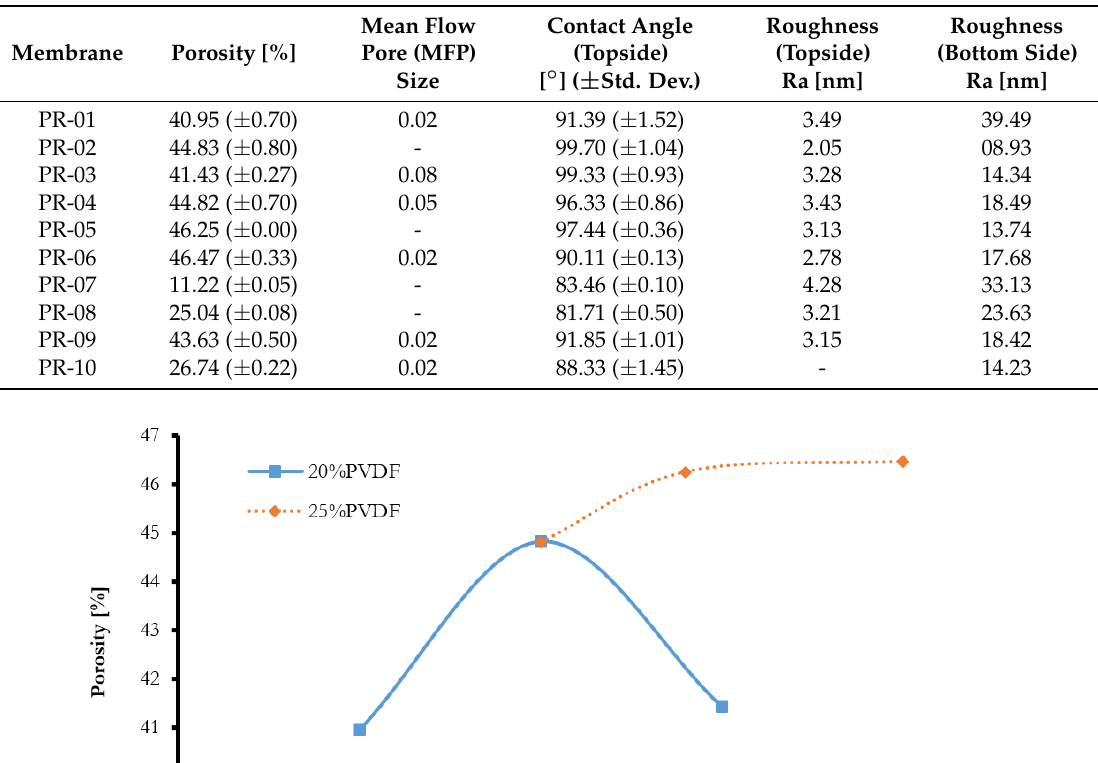
Table 4. Morphological properties of membranes.